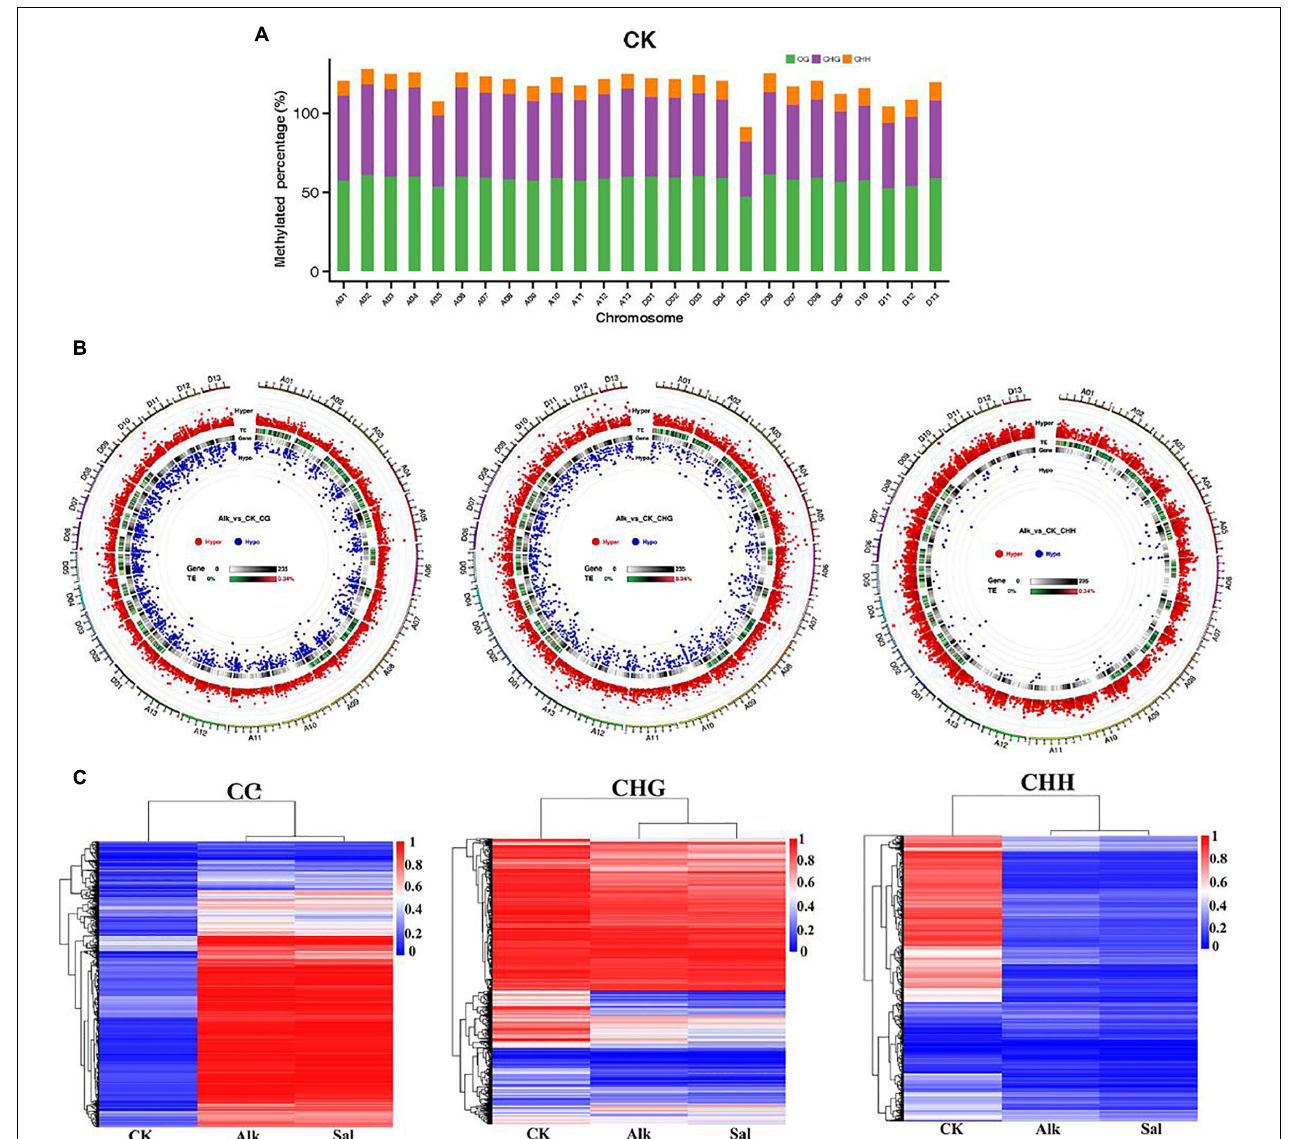
FIGURE 7 | Dynamic DNA methylation in response to salt and alkaline stress. (A) Dynamic changes of DNA methylation under stress. Different colors represent methylated C sites under different contexts, and the length of each column represents the percentage of the sequence context methylation sites in the sequence context of the chromosome. (B) The overall circos diagram of DMR in three sequence contexts (CG, CHG, and CHH). Graphic display instructions, from the outside to the inside, with the scale indicated by the color: (1) hyper DMR statistical value log5 (| areaStat|); the higher the outer dot, the larger the position difference is, and it is indicated by the red circle, (2) TE original proportion heat map, (3) gene density heat map, (4) hypo DMR statistical value log5 (| areaStat|); the higher the inward dot, the more significant the position difference. (C) Heat maps of methylation levels within CG, CHG, and CHH DMRs, respectively.